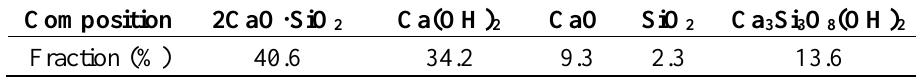
Figure 5. XRD pattern of RCP (B—2CaO·SiO 2 , P—Ca(OH) 2 , L—CaO, S—SiO 2 , R—Ca 3 Si 3 O 8 (OH) 2 ). Table 6. Chemical composition of